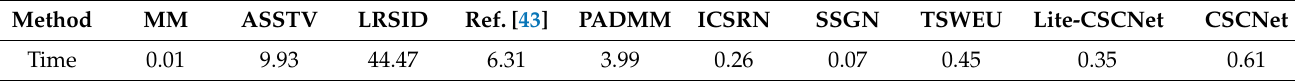
Table 7. Inference time (in seconds) of every method on the CHRIS_AM image (for one